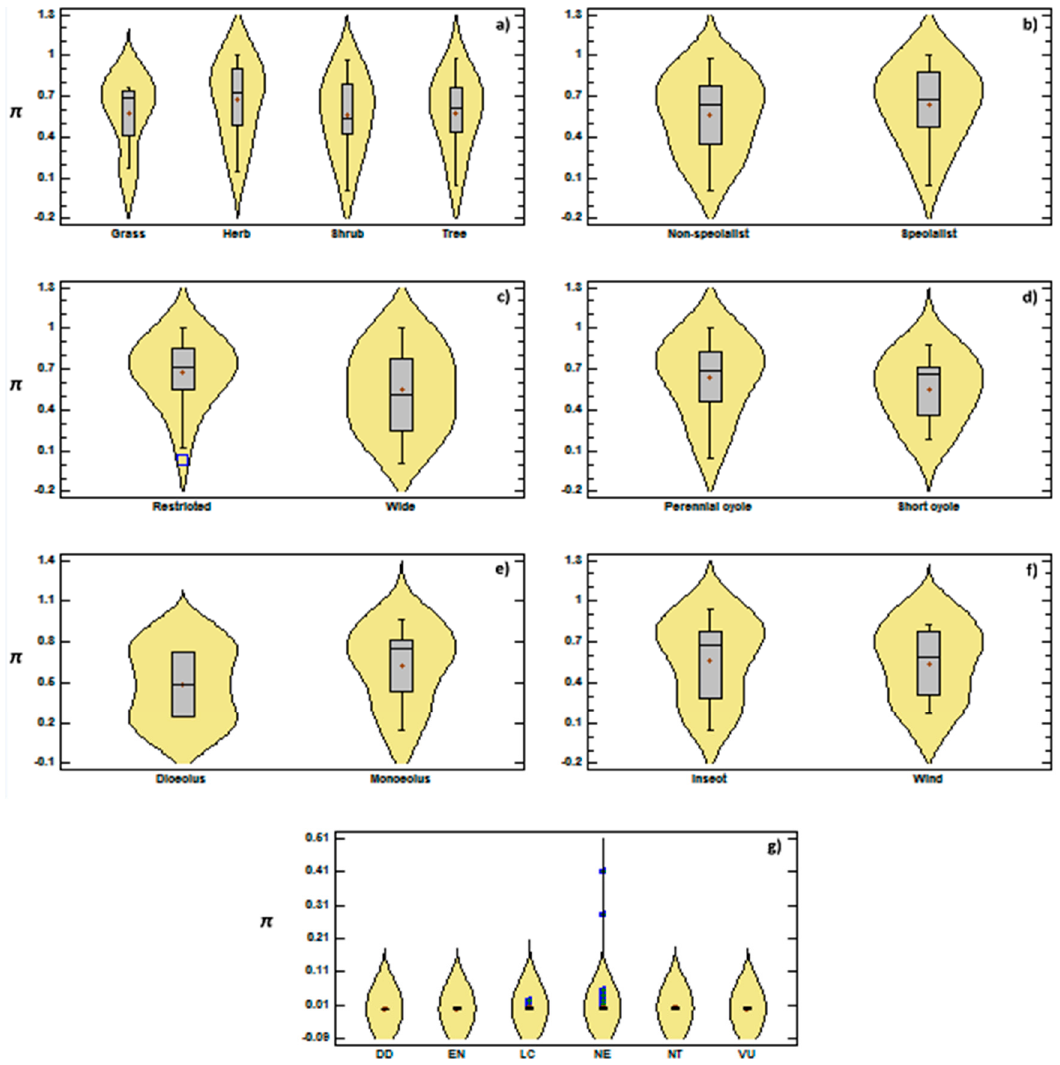
Figure 8. Mean nucleotide diversity ( π ) observed in the different angiosperm groups targeted in studies that used chloroplast markers: ( a ) life mode; ( b ) habitat specialist/non-specialist; ( c ) geographic distribution; ( d ) reproductive cycle; ( e ) type of flower; ( f ) type of pollinator, and ( g ) IUCN category. + = average; □ = outliers.